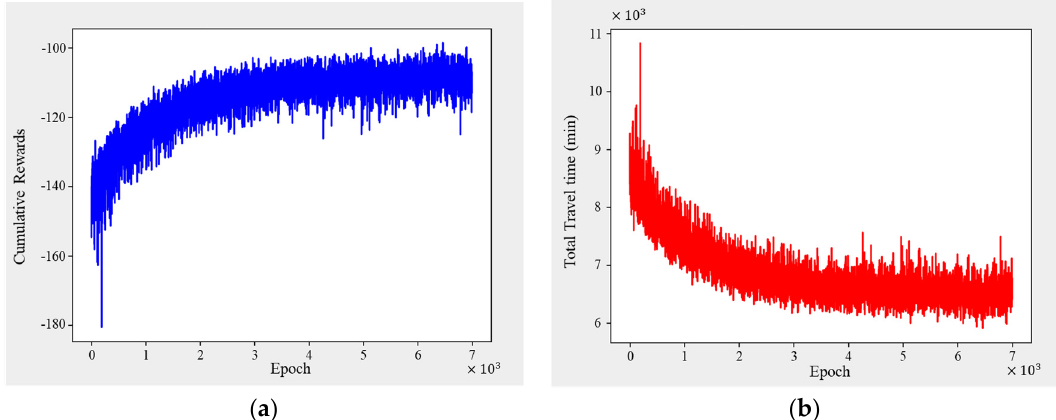
Figure 7. Cumulative rewards progress during the training process: ( a ) Convergence of cumulative